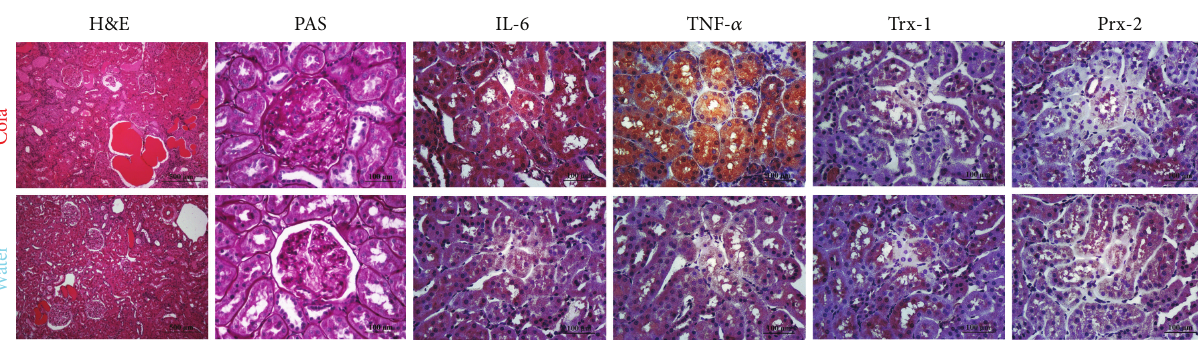
Figure 5: Immunohistochemistry of renal glomeruli and tubules before and after cola treatment. Cola treatment (C, top row) resulted in glomerulosclerosis (PAS column) and intense tubular immunopositivity for IL-6 and TNF- 𝛼 , with no major change in redoxins Trx-1 and Prx-2 immunopositive labelling compared with water drinking rats (W, bottom row). H&E: hematoxylin-eosin, PAS: periodic acid-Schiff, Trx-1: thioredoxin-1, Prx-2: peroxiredoxin-2, IL-6: interleukin-6, and TNF- 𝛼 : tumor necrosis